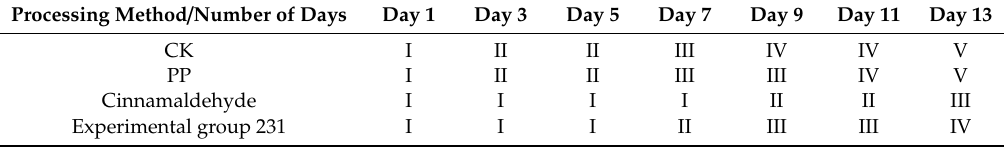
Table 6. Wrapped rot of packaged strawberries after 13 days of storage at room